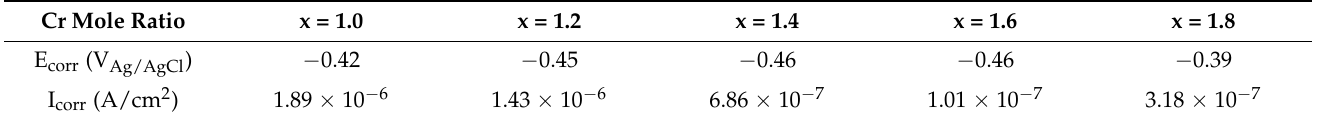
Table 4. Corrosion potential and current density of AlSi 0.5 Cr x Co 0.2 Ni (x = 1.0, 1.2, 1.4, 1.6, and 1.8) high entropy alloys.